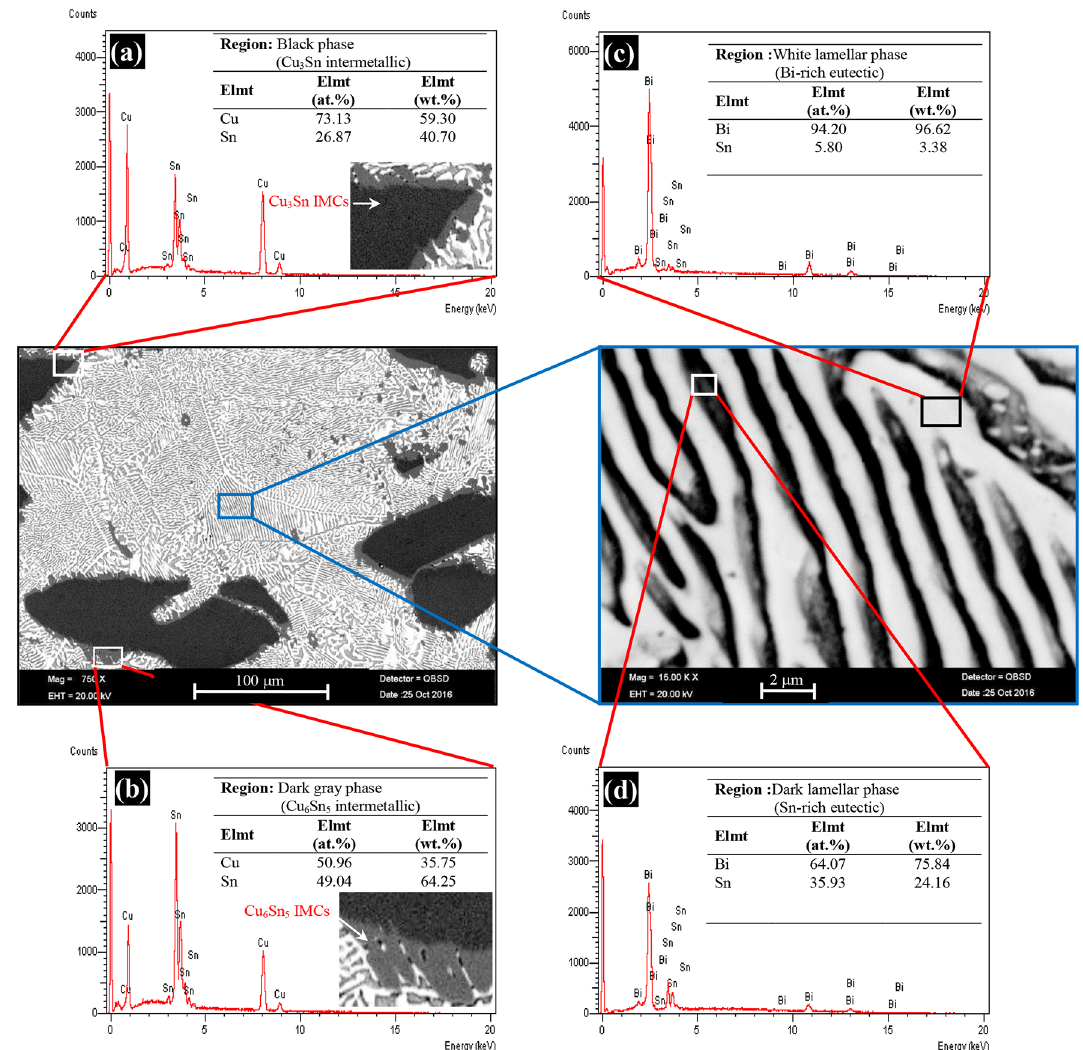
Figure 2. The chemical composition analysis of Sn-36Bi-22Cu eutectic alloy (G=4.2 K/mm, V=8.3 µm/s) by using SEM-EDX, (a) black phase (Cu